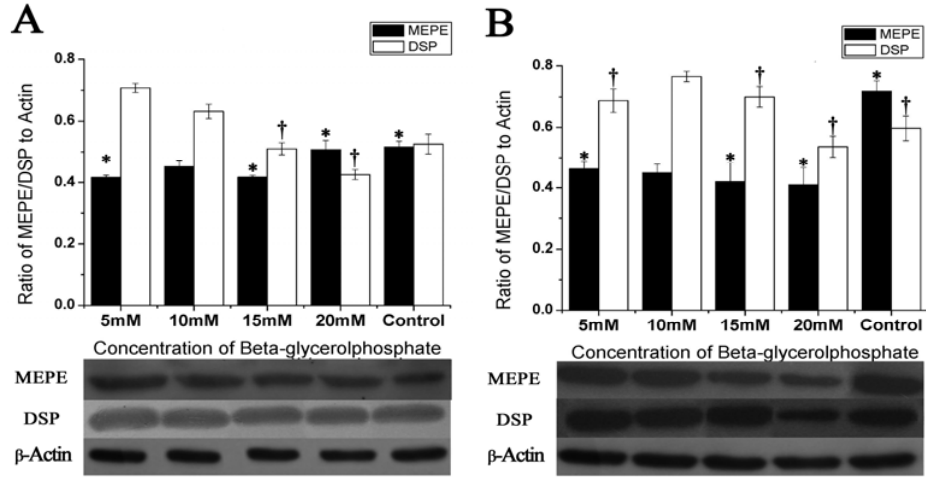
Figure 4. Western blot. Protein expression of MEPE and DSP in DPSCs culture after continuous incubation with different concentrations of β -glycerolphosphate. The relative protein expression was calculated by dividing the absolute level of expression of MEPE and DSP with the absolute level of expression of β -actin at 4 time points, at days 7 ( A ), 14 ( B ), 21 ( C ), 28 ( D ). Each point represents the value calculated from three different cell samples with the same cell sample in triplicate. * MEPE significant difference against 10 mM β -glycerolphosphate group, p < 0.05. † DSP significant difference against 10 mM β -glycerolphosphate group, p <